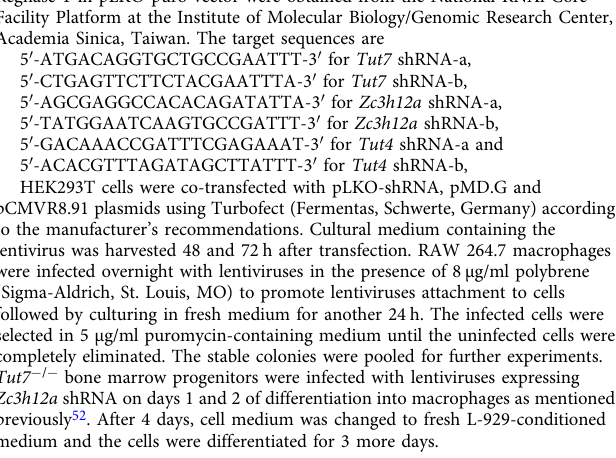
Reagents and antibodies . Anti-TUT7 polyclonal antibody (1:1000 for immuno- blotting and 1:50 immunoprecipitation) was produced by immunizing rabbits